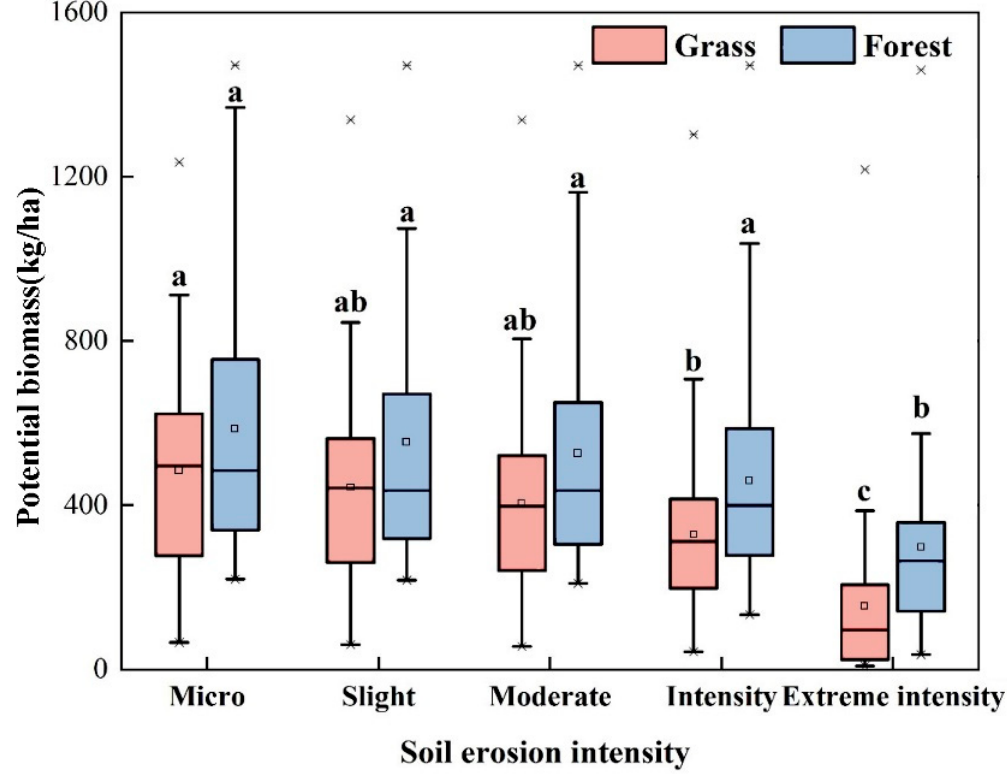
Figure 11. Potential biomass of forest and grass under di ff erent soil erosion intensity. ( * represent outliers; Significant difference analysis was performed using the letters a, b and c to label the results outliers; Signi fi cant di ff erence analysis was performed using the le tt ers a, b and c to label the re- of the differences, the same letter indicates a non-significant difference, different letters indicate a sults of the di ff erences, the same le tt er indicates a non-signi fi cant di ff erence, di ff erent le tt ers indi- significant cate a signi fi cant di ff erence).